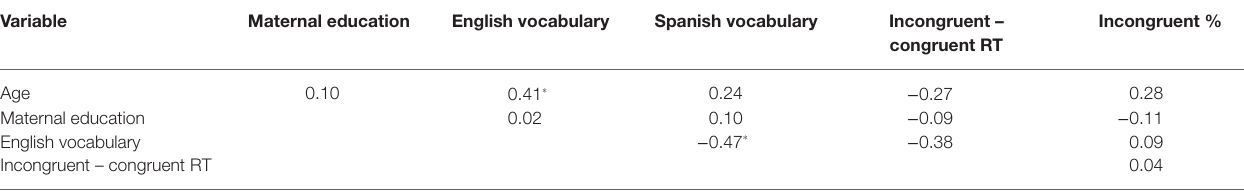
TABLE 4 | Correlation matrix between demographic, vocabulary, and inhibitory control measures in the monolingual children ( n = 20).